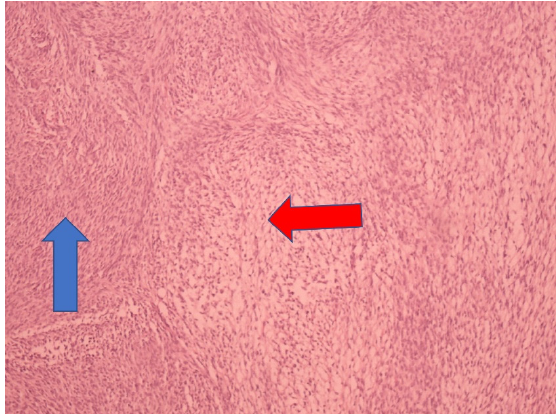
Figure 3. Microscopic appearance under HE staining (100×, spindle-shaped tumor cell—blue arrow, oval to round tumor cells—red arrow). Immunohistochemically, the spindle-shaped tumor cells were positive for vimentin and SMA (smooth muscle actin), whereas the more abundant and brighter spindle-to- coastal shaped cytoplasmic cells tested positive for vimentin and inhibin and histochemically positive for oil red O (Figure 4).